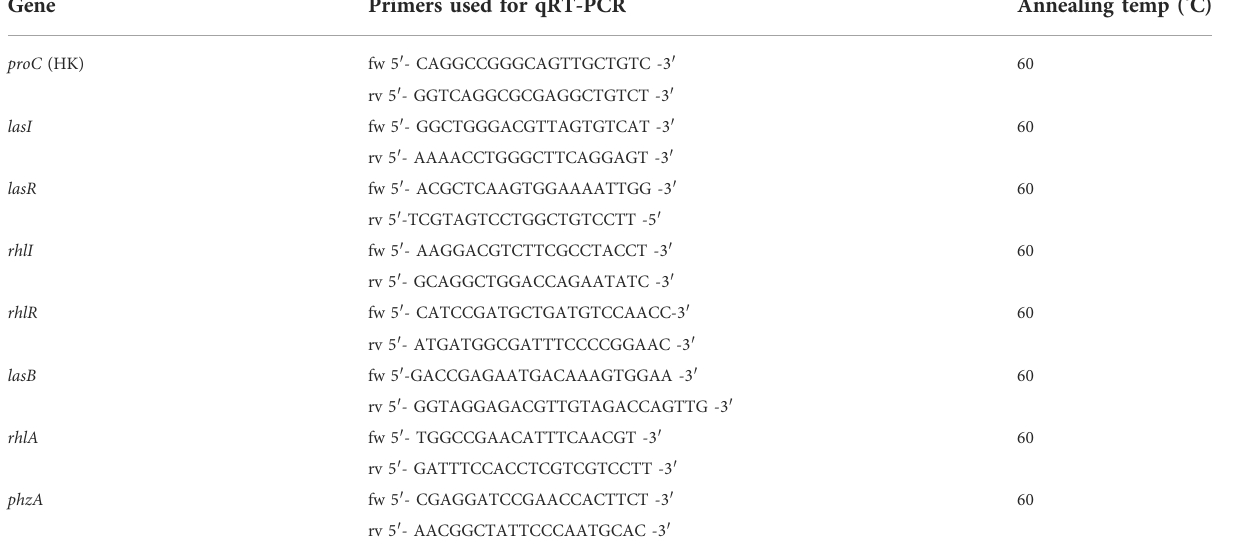
TABLE 1 Oligonucleotides sequences and annealing conditions used in the qRT-PCR experiments. Gene Primers used for